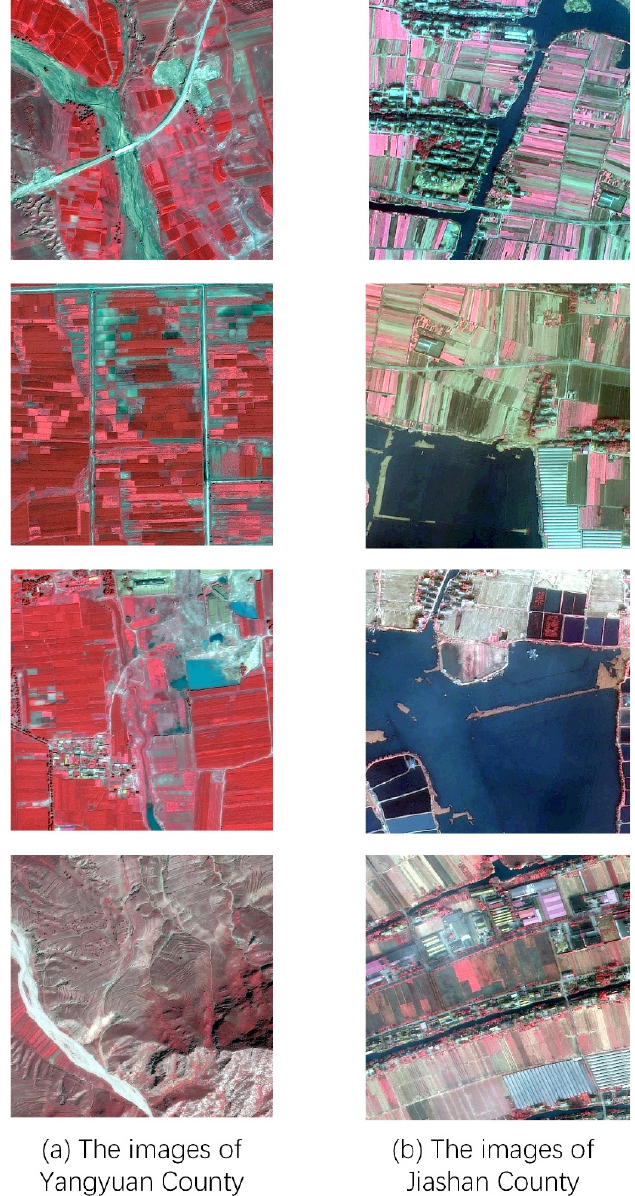
Figure 2. Sample images between ( a ) Yangyuan County and ( b ) Jiashan County. The distance between the two selected regions is approximately 2000 km. Yangyuan County is in a basin with a wide distribution of mountainous areas. Jiashan County is in a plain, with a large proportion of water. There are obvious differences in the topography and landforms of the two